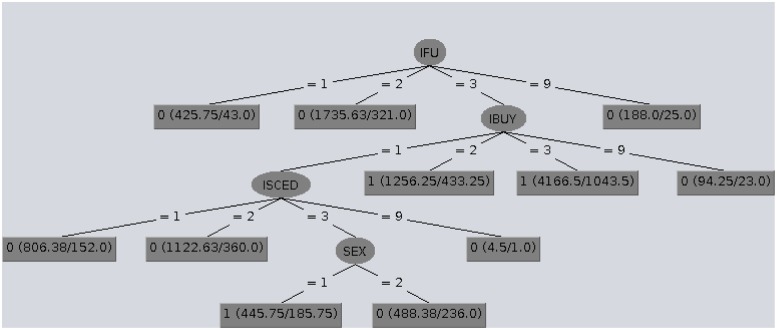
CTC tree obtained for Belgium which has a low EGUI+ level.